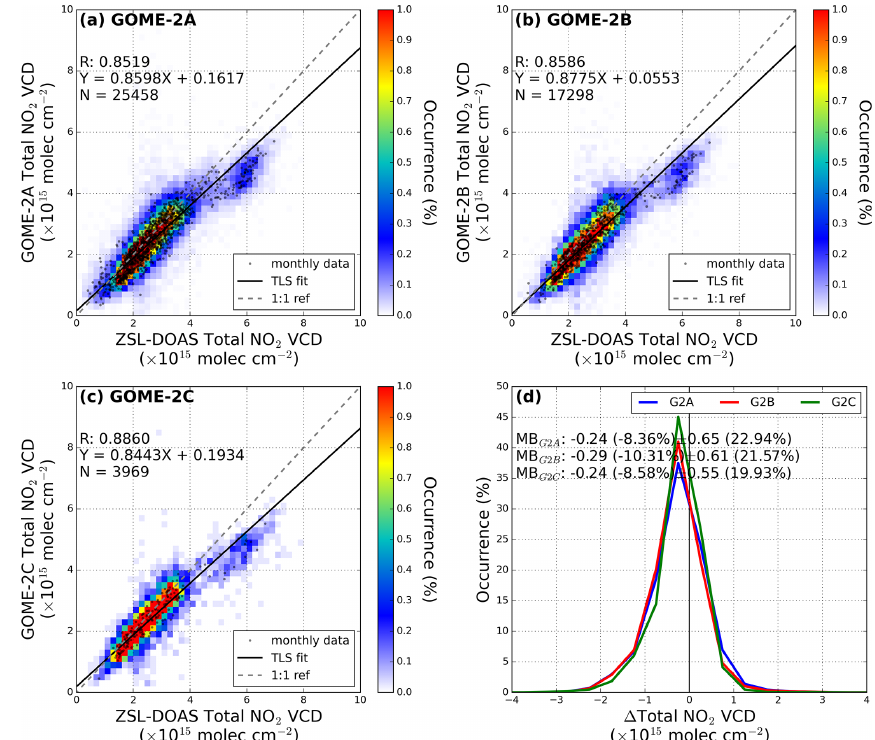
Figure 14. Comparison of daily and monthly total column NO 2 measured by the ground-based ZSL-DOAS to (a) GOME-2A, (b) GOME- 2B, and (c) GOME-2C. Histograms of the difference in total column NO 2 between GOME-2 and ZSL-DOAS observations are shown in panel (d) . Co-located daily and monthly averaged data are used in the comparison. Total least-squares regression is based on daily data.